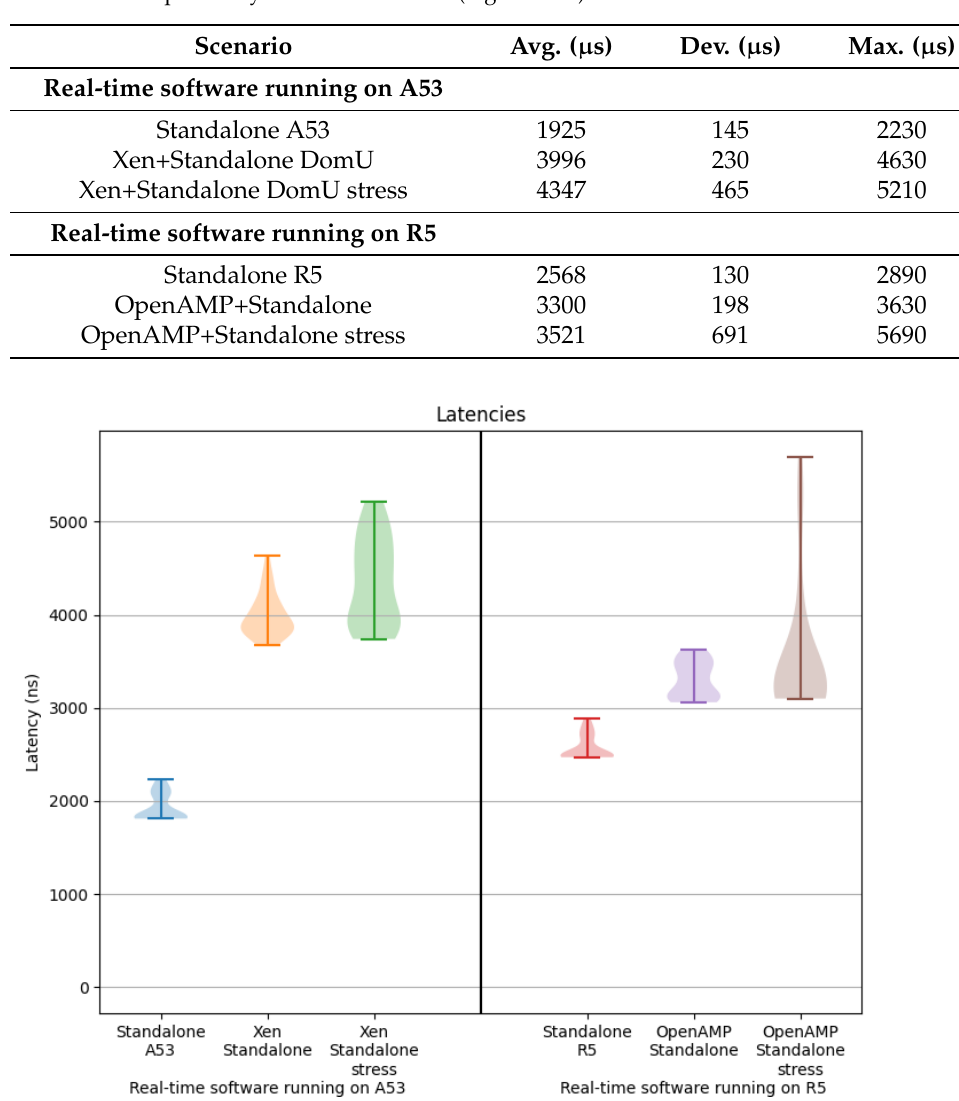
Figure 10. Interrupt latency for 3 to 6 scenarios (Figures